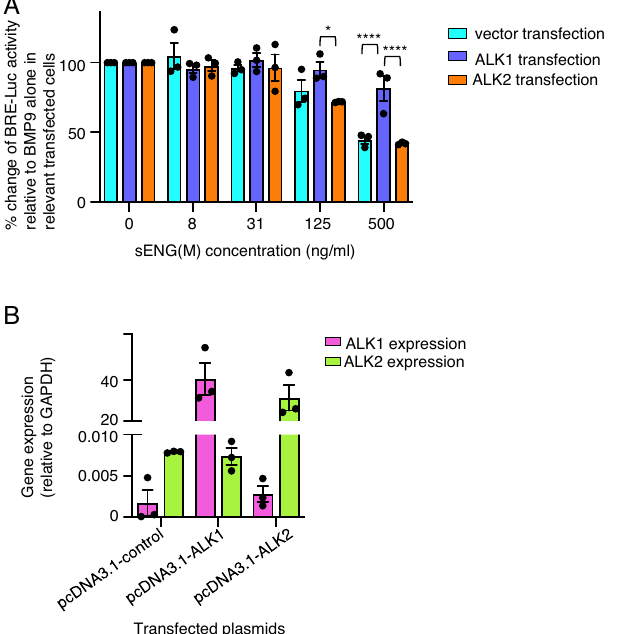
Figure 5. ALK1 but not ALK2 transfection reduced the inhibitory effect of sENG on BMP9 signaling in C2C12 BRE luciferase assay. ( A ) C2C12 BRE-luc cells were transfected with pcDNA3.1-control (cyan bars), pcDNA3.1- ALK1 (blue-purple bars) or pcDNA3.1-ALK2 (orange bars) and treated with BMP9 (1 ng/ml) combined with increasing doses of sENG(M). Cells were treated for 18 h and luciferase activity was measured and normalized to the BMP9 only treatment controls in the relevant transfected cells. Three independent transfection experiments were performed, and data shown as Mean ± SEM. Two-way ANOVA comparing sENG effect on BMP9 signaling in receptor-transfected and vector control-transfected cells, * P < 0.05, **** P < 0.0001. ( B ) Relative gene expression of ALK1 and ALK2 measured by RT-qPCR in transfected cells. Gene expression relative to GAPDH from three independent experiments are